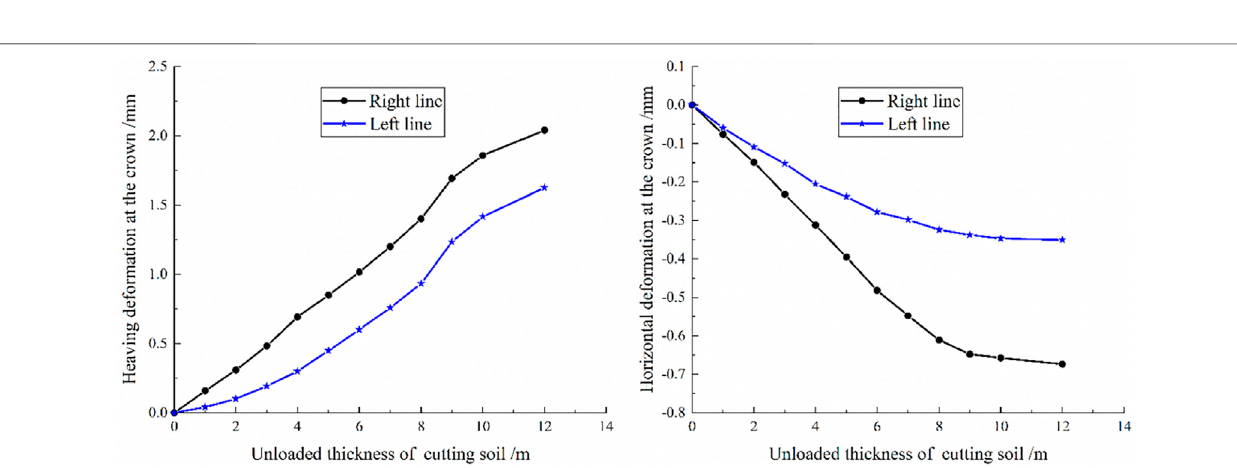
FIGURE 13 | The maximum deformation of the tunnel under different unloaded